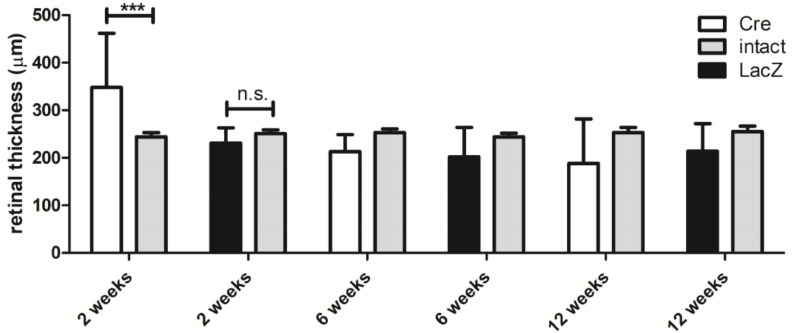
Figure 1. Mean retinal thickness measured by optical coherence tomography at different time points compared with the intact eye of the same animal measured before the injection. Results are presented as mean ± standard deviation (SD). *** p ≤